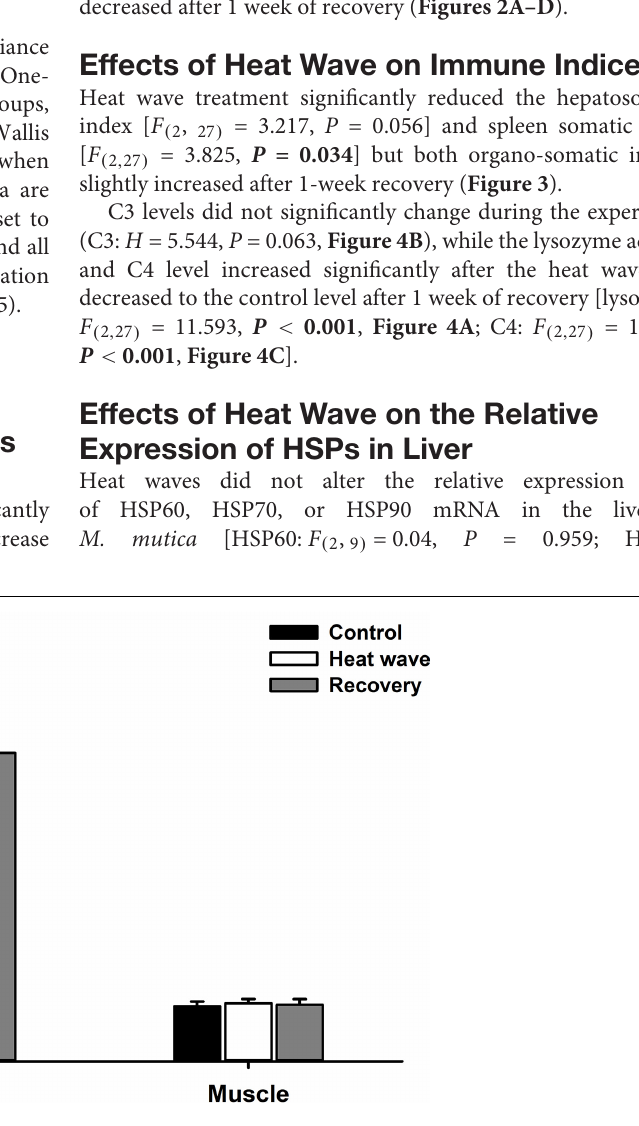
Frontiers in Ecology and Evolution |